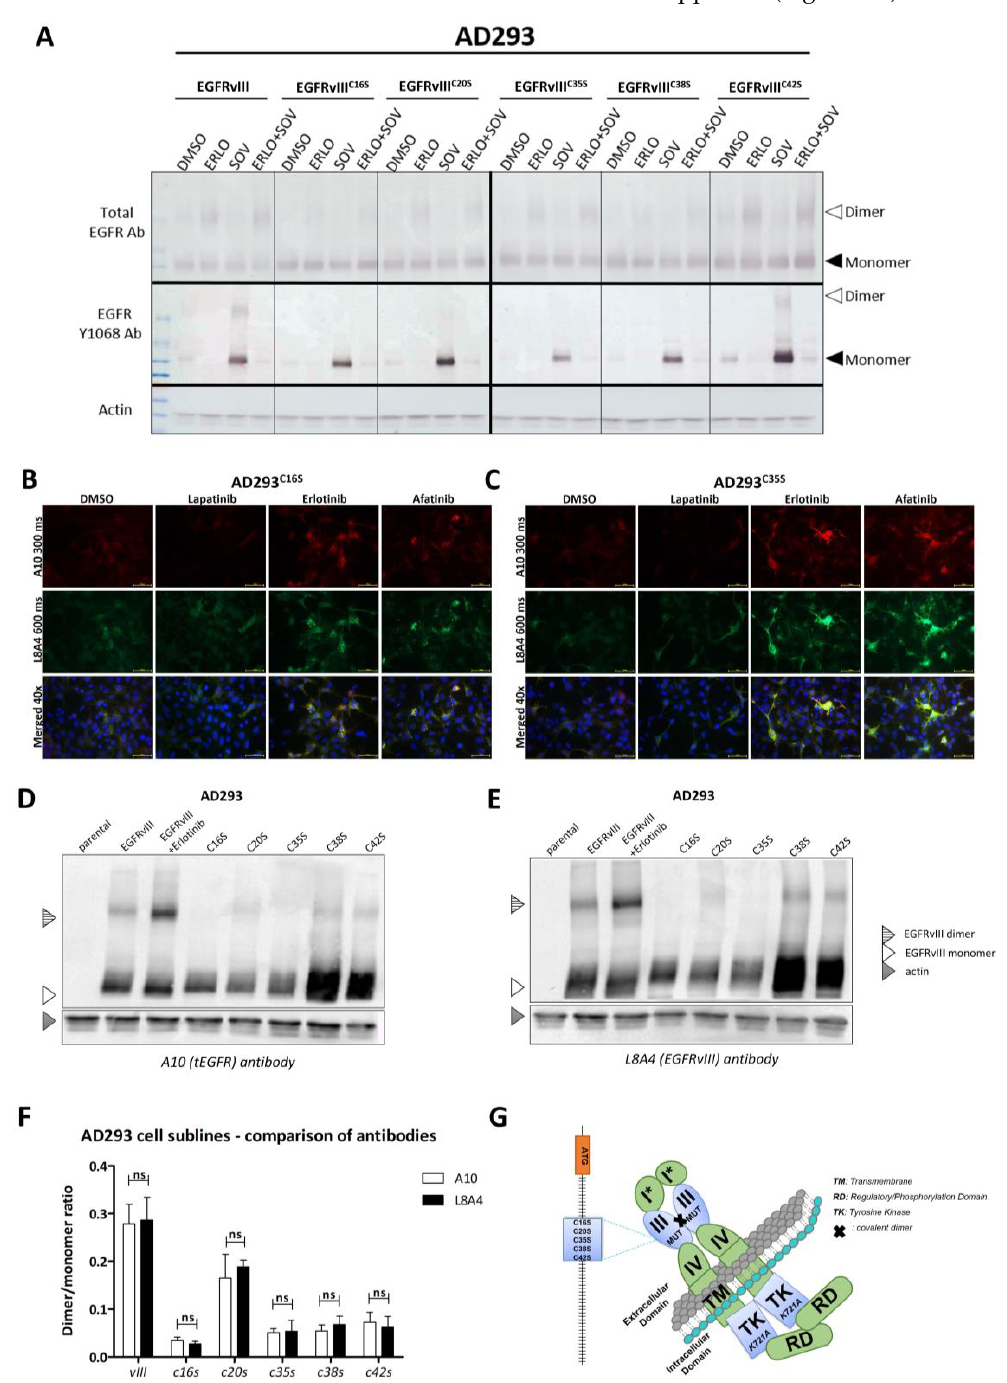
Figure 5. Validation of in silico models performed by in vitro testing of the different EGFRvIII cysteine–serine mutants. ( A ) Semi-native Western blot analysis of dimer formation ability in the case of AD293 cell line expressing EGFRvIII and EGFRvIII cysteine – serine mutants, C16S, C20S, C35S, C38S, and C42S in the presence of erlotinib, SOV, and a combination of both. ( B , C ) The influence of particular TKIs (10 µM erlotinib, 0.5 µM afatinib, and 10 µM lapatinib) on total EGFR amount was also investigated by immunocytochemical staining of AD293 C16S ( B ) and AD293 C35S ( C ) cell lines. In both cases, erlotinib and afatinib increased, whereas lapatinib decreased the accumulation of EG- FRvIII protein. ( D , E ) Semi-native Western blot on AD293 parental, vIII, C16S, C20S, C35S, C38S and C42S cell lines was performed to elucidate whether different disulfide bridge arrangements may